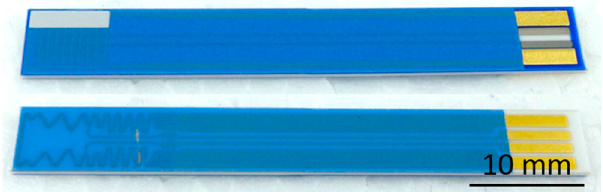
Figure 3. New thermoelectric sensor with LTTT layer laminated on alumina substrate.